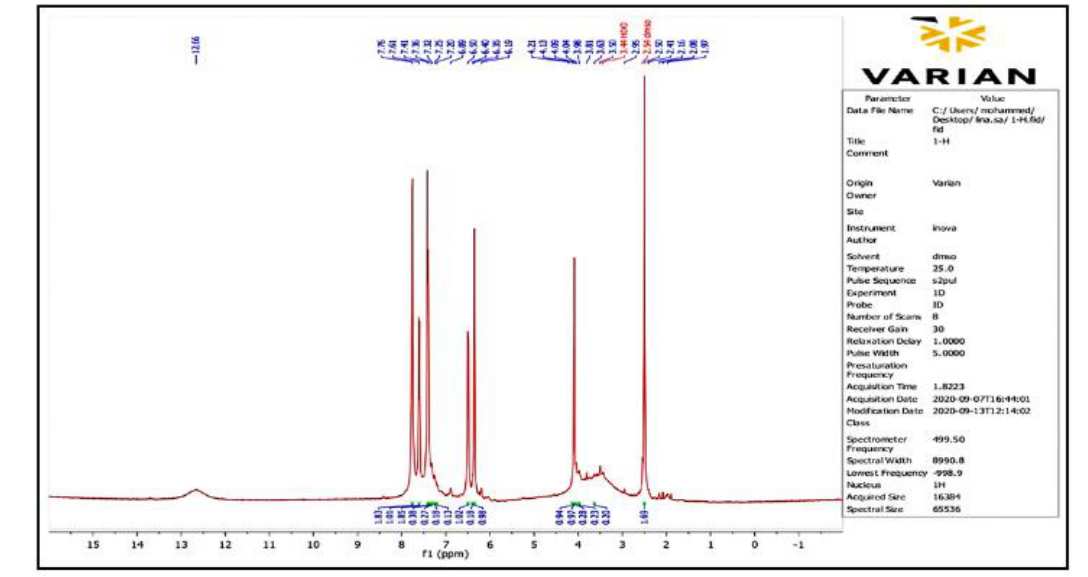
Fig. 3. 1 H NMR spectra of